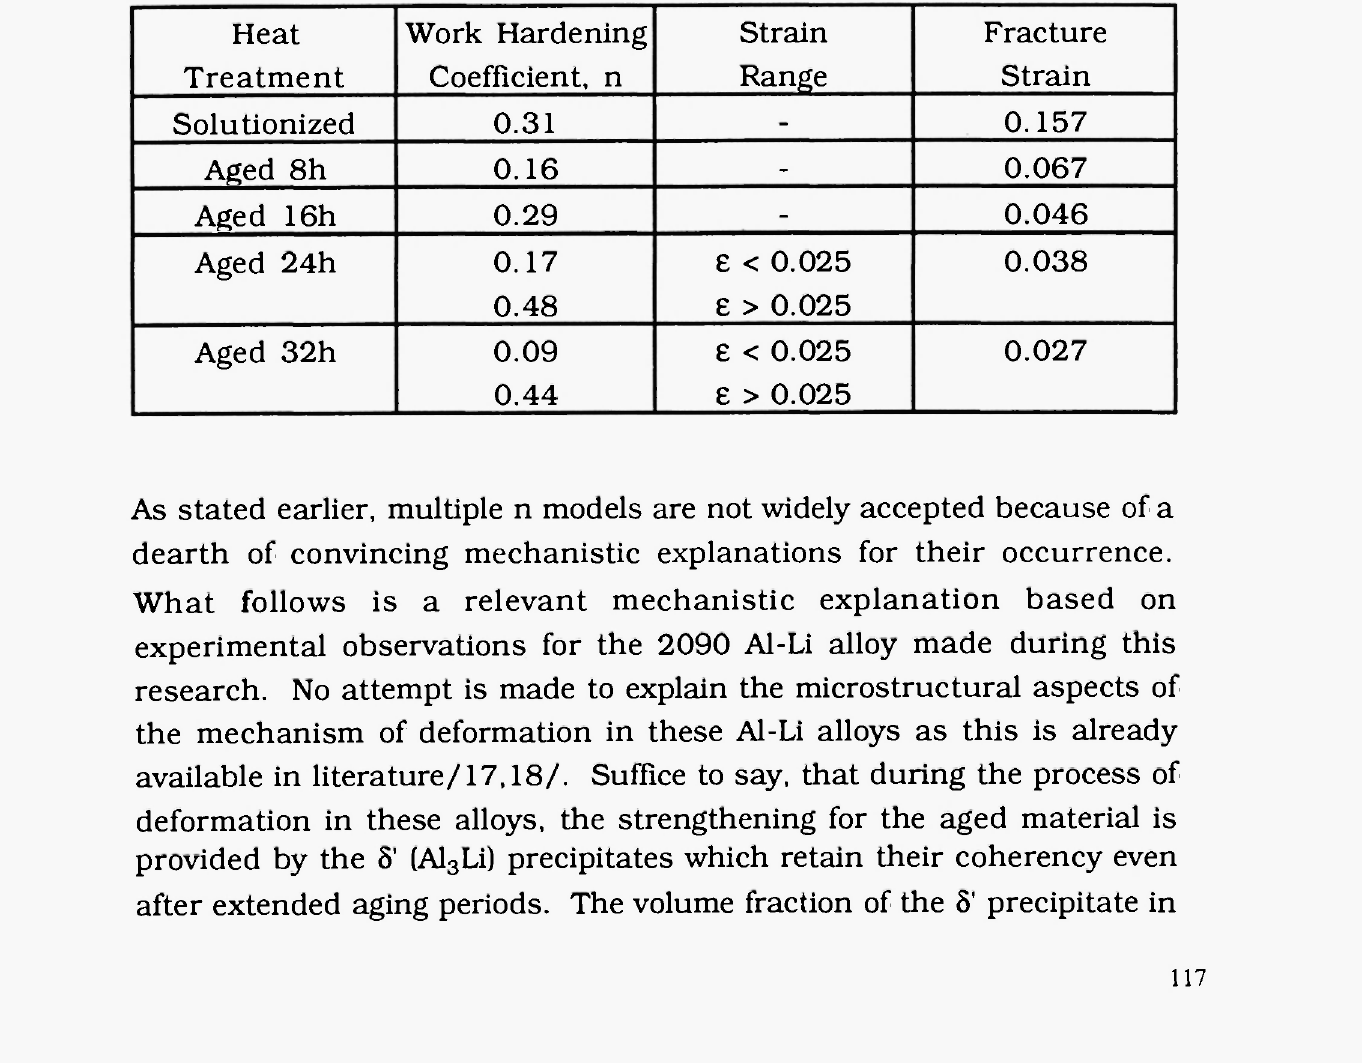
TABLE 1. η values and corresponding strain ranges for the specimens. Heat Work Hardening